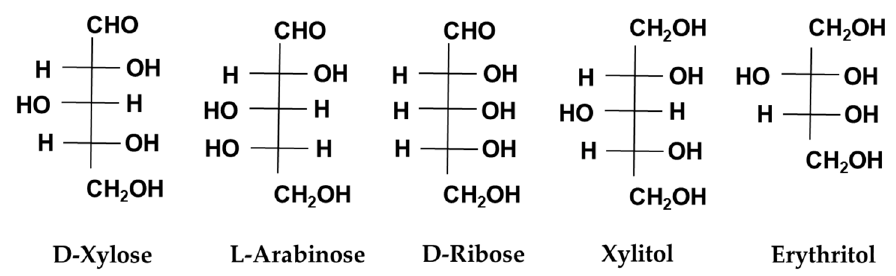
Figure 7. Pentoses and sugar alcohols in the food industry.